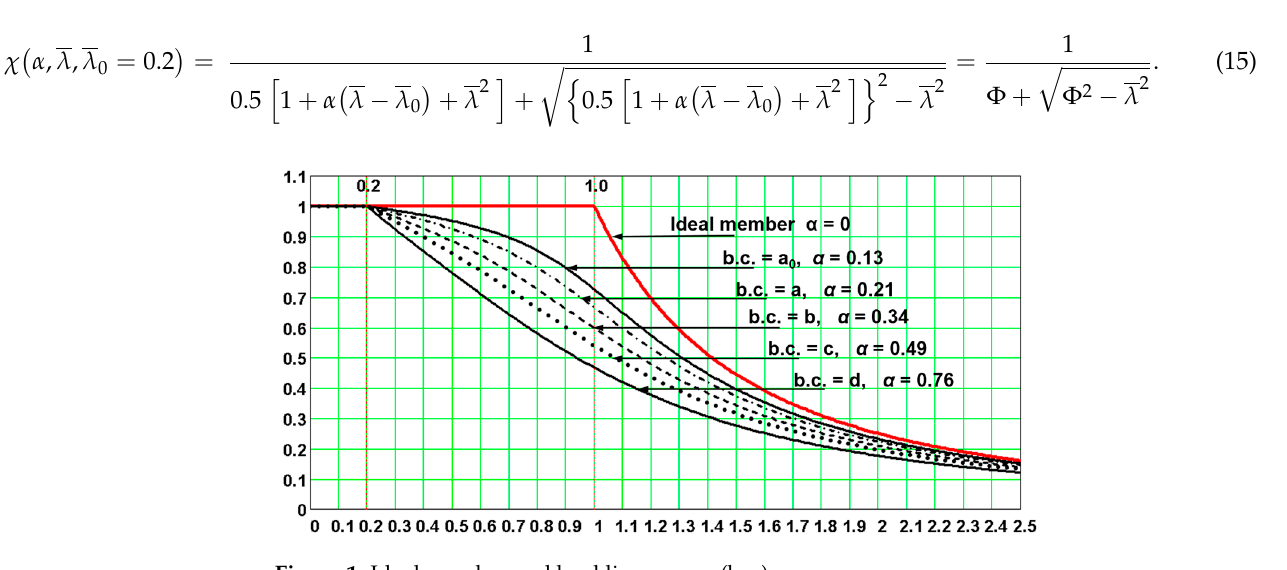
Figure 1. Ideal member and buckling curves (b.c.).